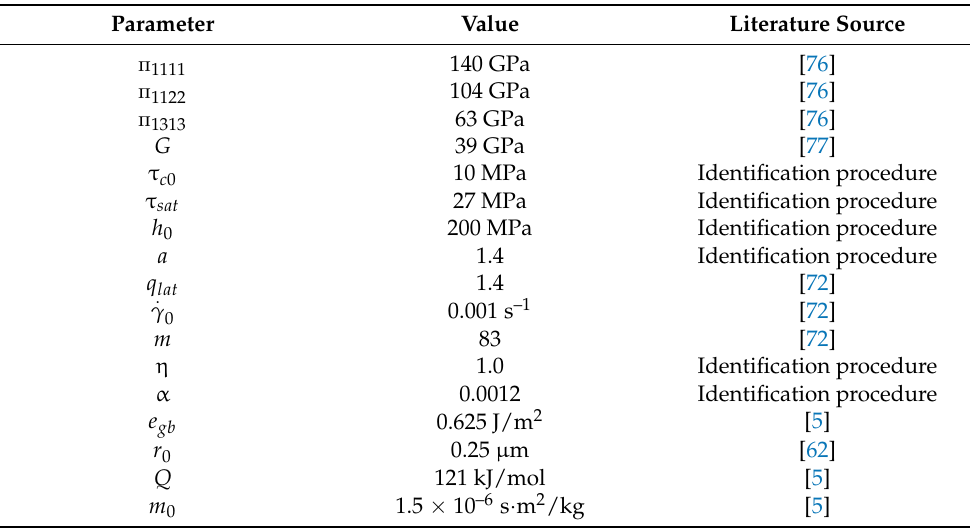
Table 1. The parameters of the multilevel model of inelastic